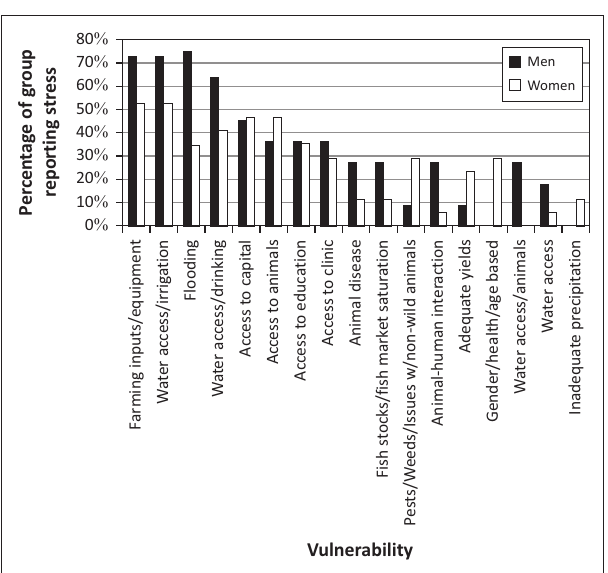
FIGURE 15: The gendered vulnerability context of Group S. (Figure 15). In Group S, 75 % of the men mentioned flooding as a stressor without being prompted, as opposed to only 35.3 % of women. Therefore, for men in this group, flooding is the single most important stressor they face whereas for